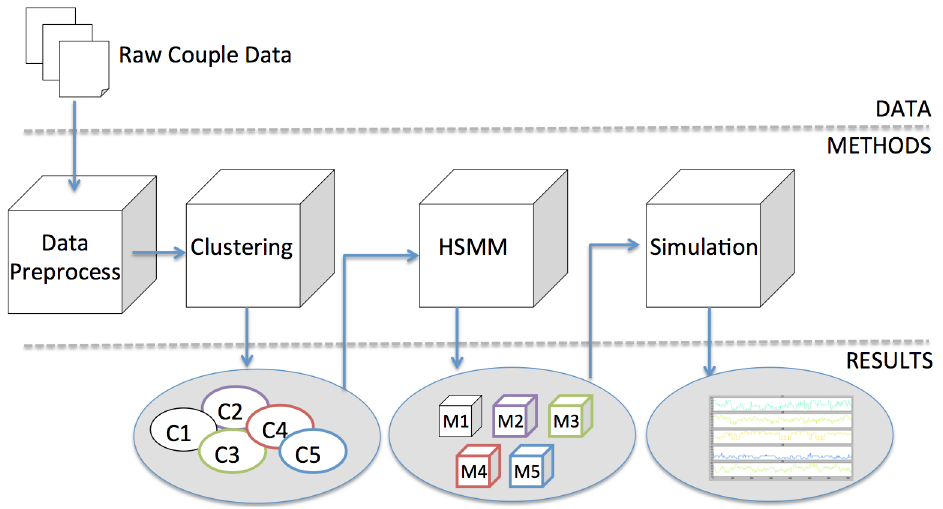
Fig 1. Process Flow Of Data Preparation, Modeling, and